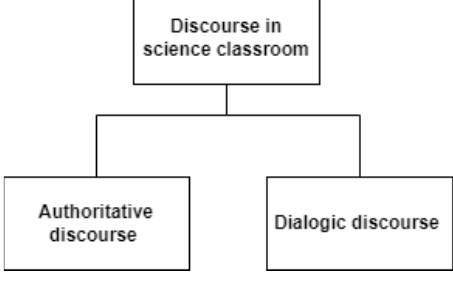
Figure 2: Discourse in science